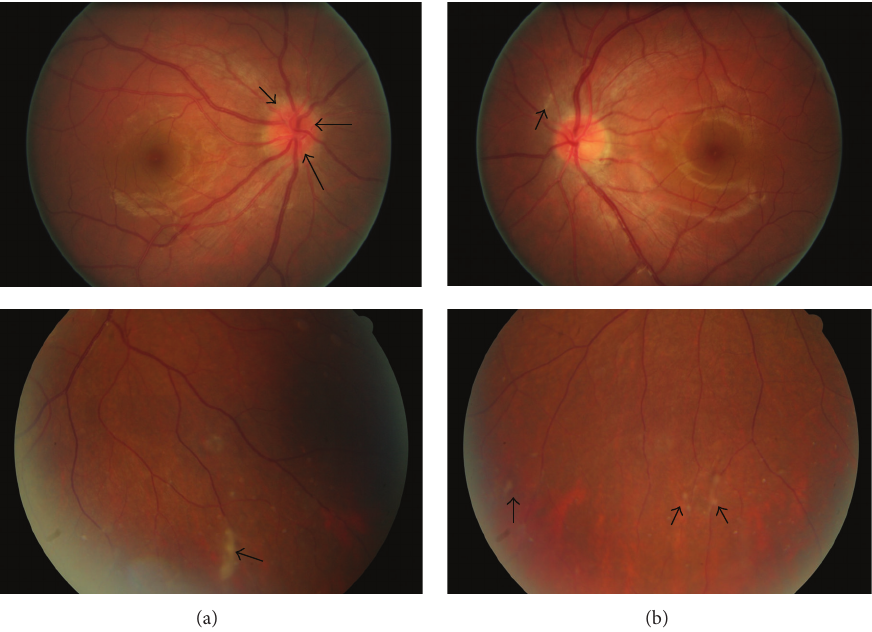
Figure 1: Color fundus photographs taken at initial presentation. (a) Right eye, the disc was hyperemic and its margin was slightly blurred (black arrows). Vitreous clumping and large yellow spots of chorioretinitis were seen in the inferior retina (black arrows). (b) Left eye, multiple small yellow spots of chorioretinal inflammation at the posterior pole and inferior retina (black